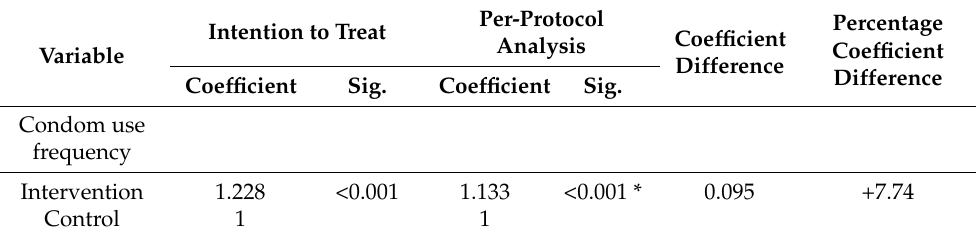
Table 5. Comparison of fixed coefficients for the group, with and without.